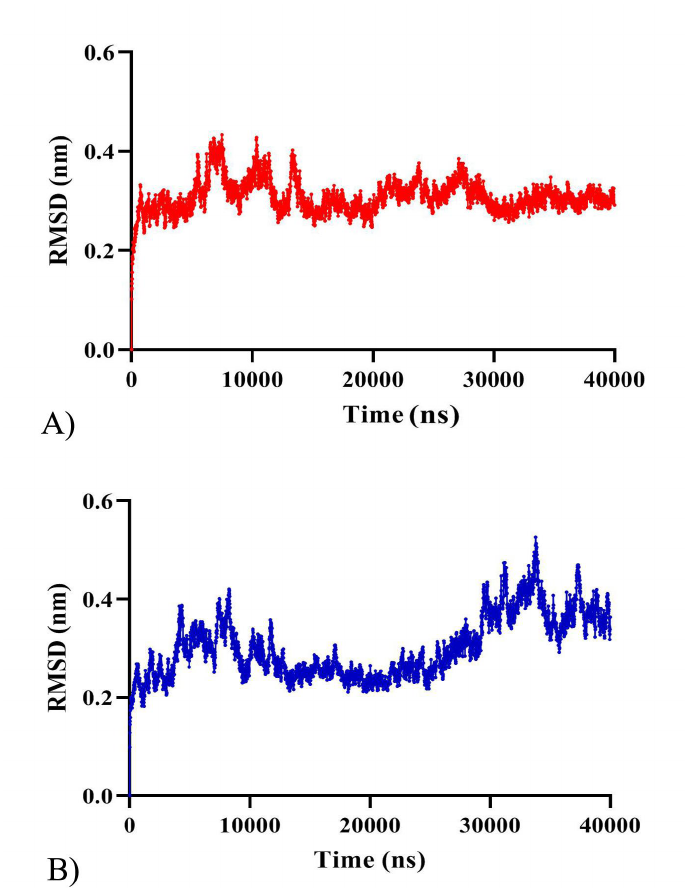
FIGURE 6 - RMSD plots versus time; A) RMSD of the backbone atoms of scFv/HER2; B) RMSD of the backbone atoms of the fusion